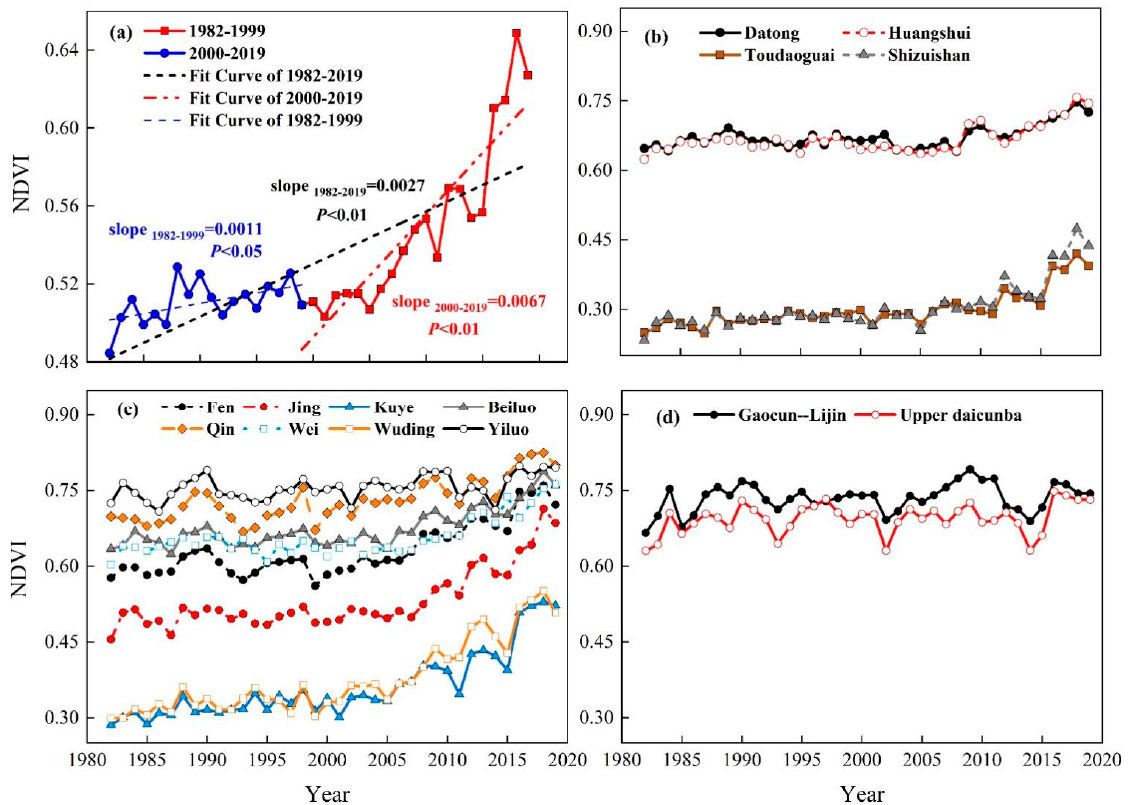
Figure 4. Temporal variation in the NDVI levels in the YRB and sub-basins. ( a ) Temporal variation in the NDVI levels in the YRB from 1982 to 2019 and two sub-periods, ( b ) four sub-basins in the UYRB, ( c ) eight sub-basins in the MYRB, and ( d ) two sub-basins in the LYRB. NDVI: normal difference vegetation index; YRB: Yellow River Basin; UYRB: Upper Yellow River Basin; MYRB: Middle Yellow River Basin; LYRB: Lower Yellow River Basin.